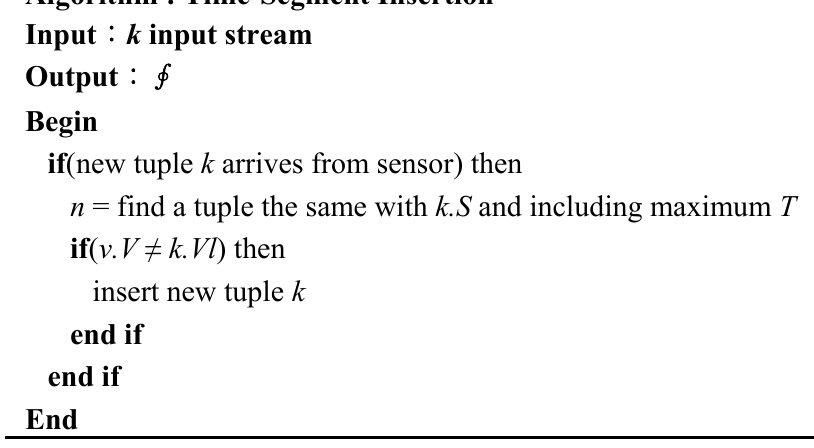
Figure 4. Time-Point Insertion